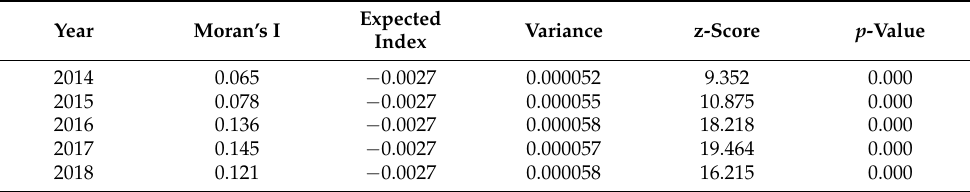
Table 1. Global Moran’s I of cyber fraud distribution in China from 2014 to 2018.